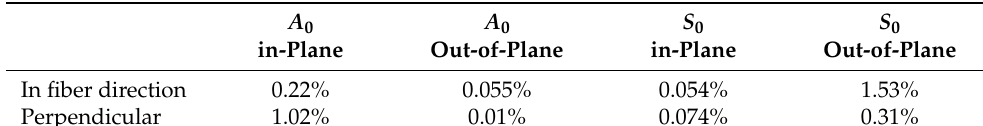
Table 5. Calculated mean error for the 3D model at 120kHz.